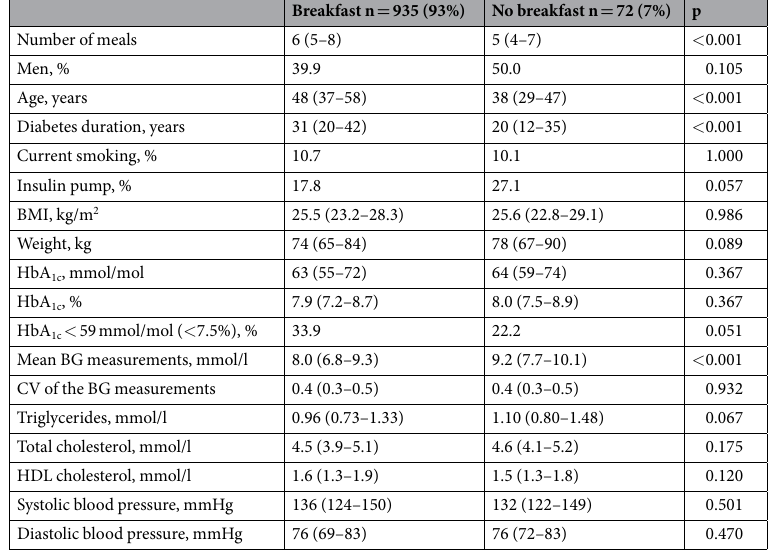
Table 3. Participant characteristics divided by breakfast consumption. Data are presented as frequency (%) or median (interquartile range). BMI, body mass index; BG, blood glucose; CV, coefficient of